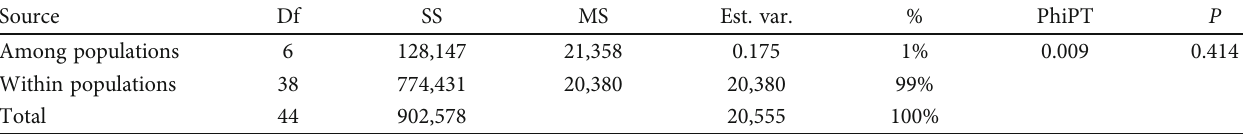
Table 7: Analyses of molecular variance (AMOVA) for Alternaria isolates by SRAP markers.